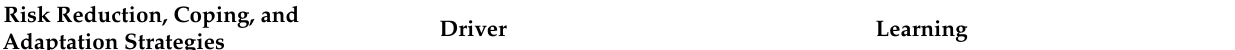
Table 4. Coping and adaptation initiatives by nonprofit